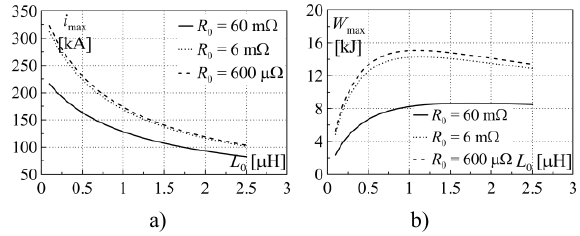
Fig. 4. The characteristics of the: a) maximum value of the generated current i max in the system as a function of the load inductance L 0 and b) the maximum energy W max of the magnetic field accumulated in the load coil as a function of the inductance L 0 (for three values of its resistance R 0